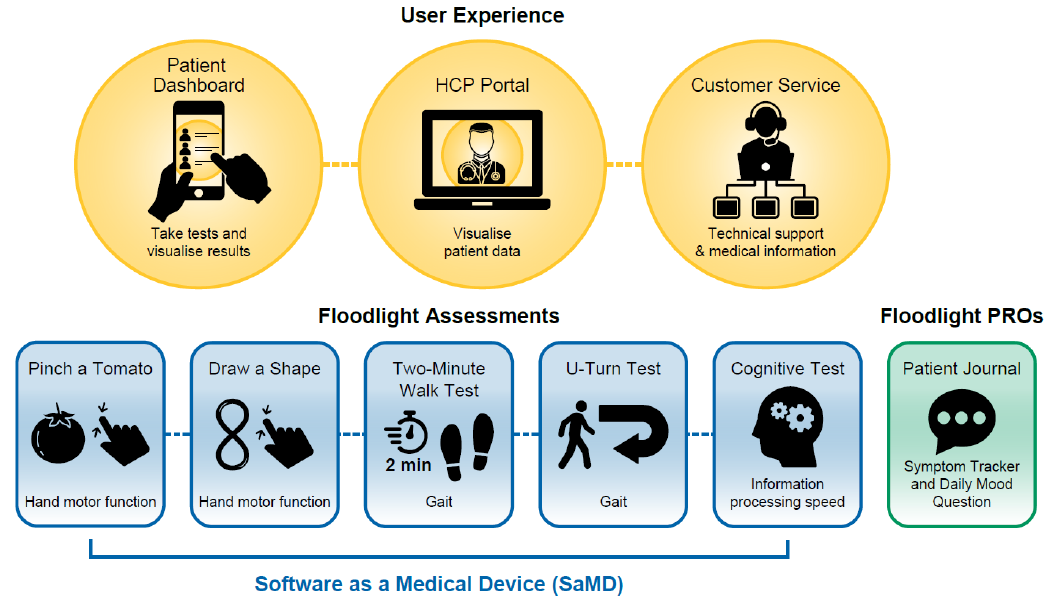
Figure 2. Illustration of current version of Floodlight™ MS v1.2 app and assessments. HCP, healthcare professional; PRO, patient-reported outcome.